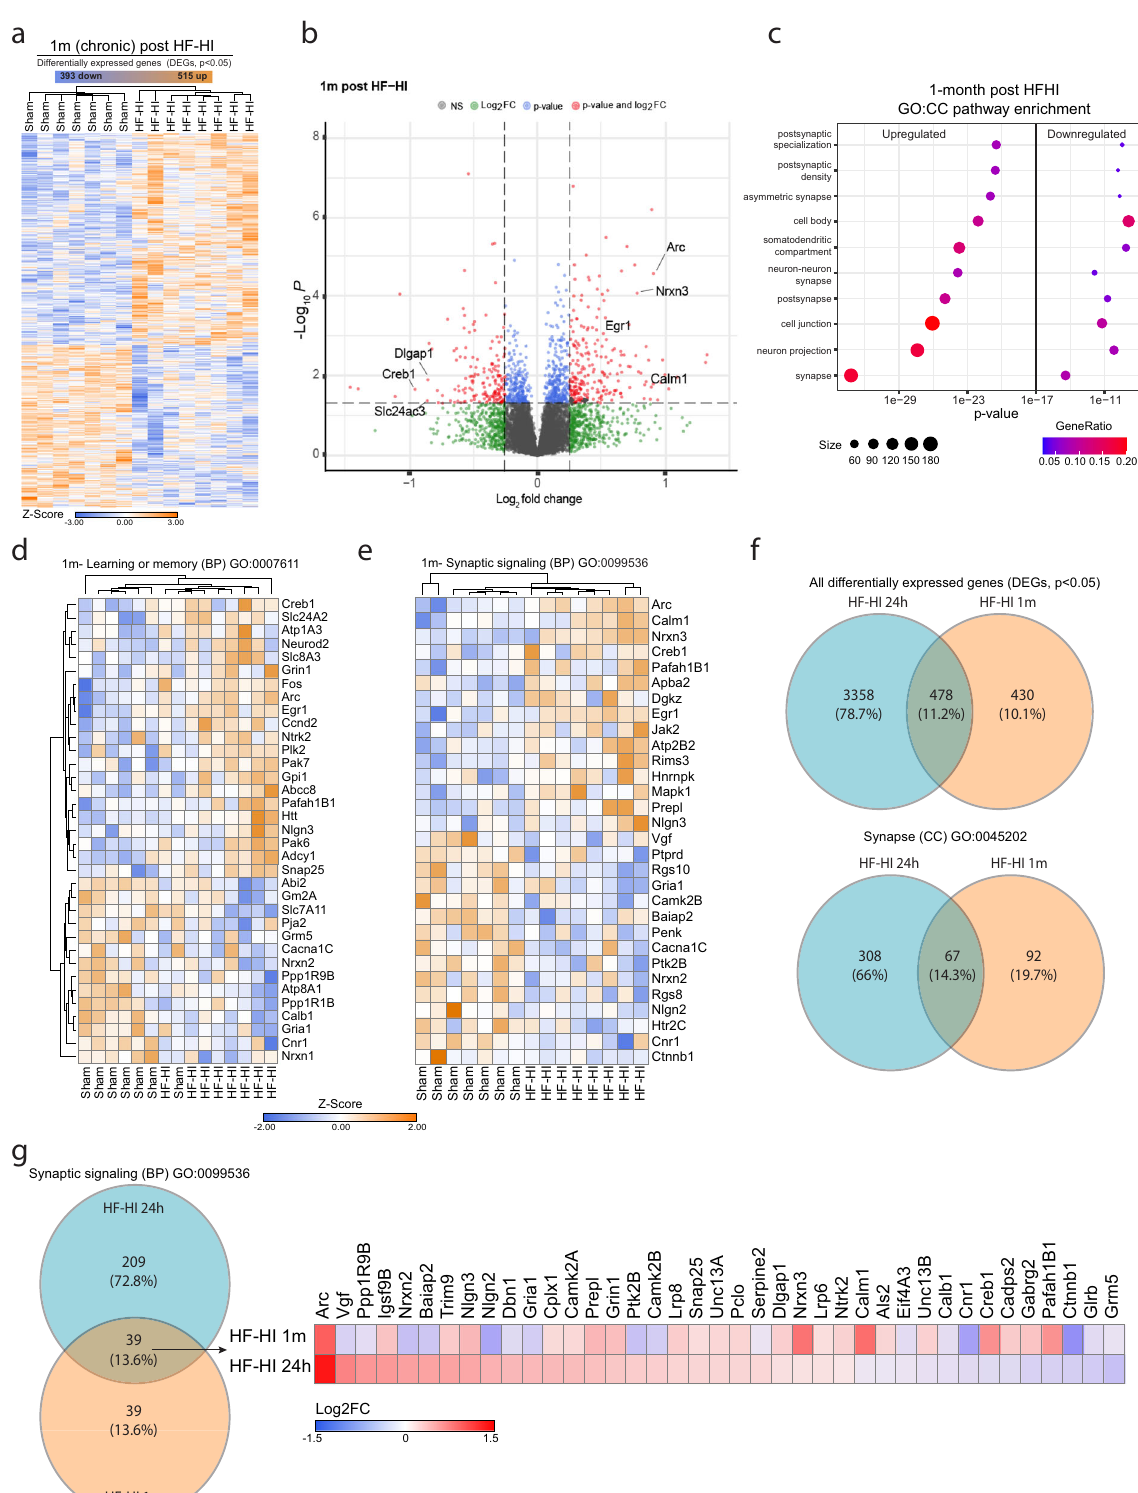
(Fig. 6m), cellular input resistance (Supplementary Fig. 5H), or capacitance (Supplementary Fig.